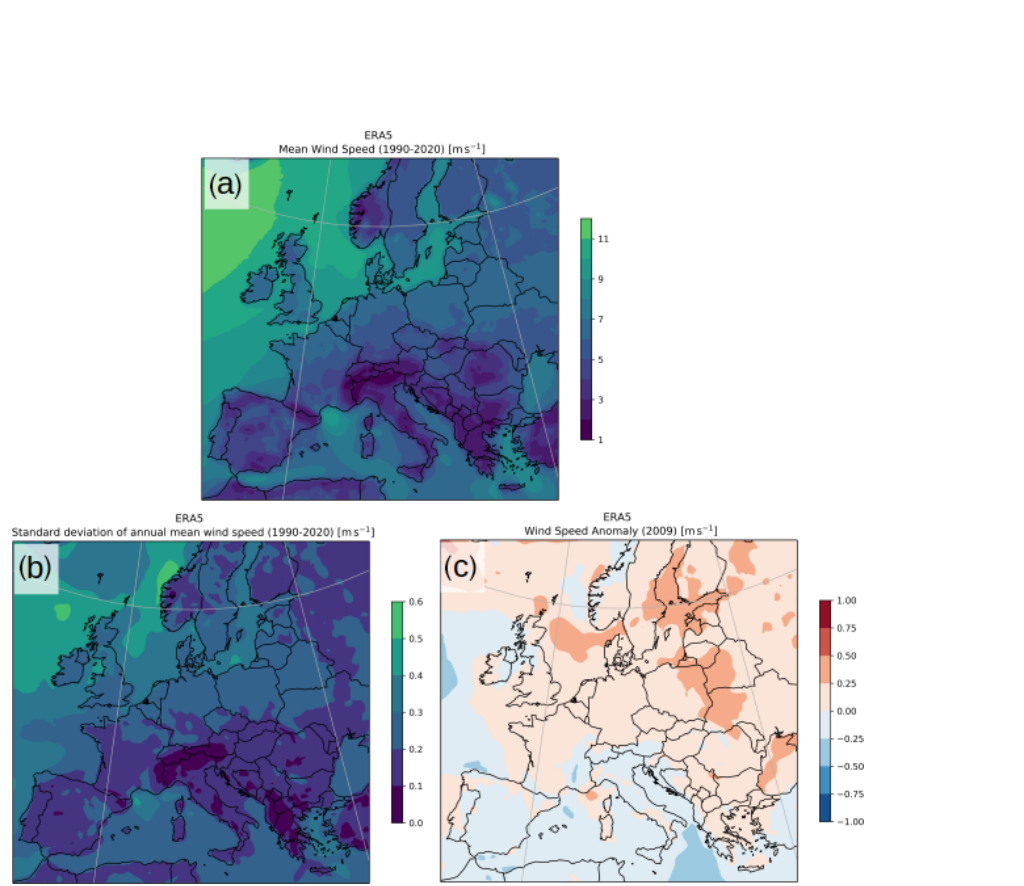
Figure A1. (a) Long-term mean wind speed and (b) standard deviation of the annual mean wind speed (1990–2020) and (c) wind speed anomaly during 2009 with regards to the long-term mean. All statistics are computed using ERA5 at 100ma.g.l. (above ground level).